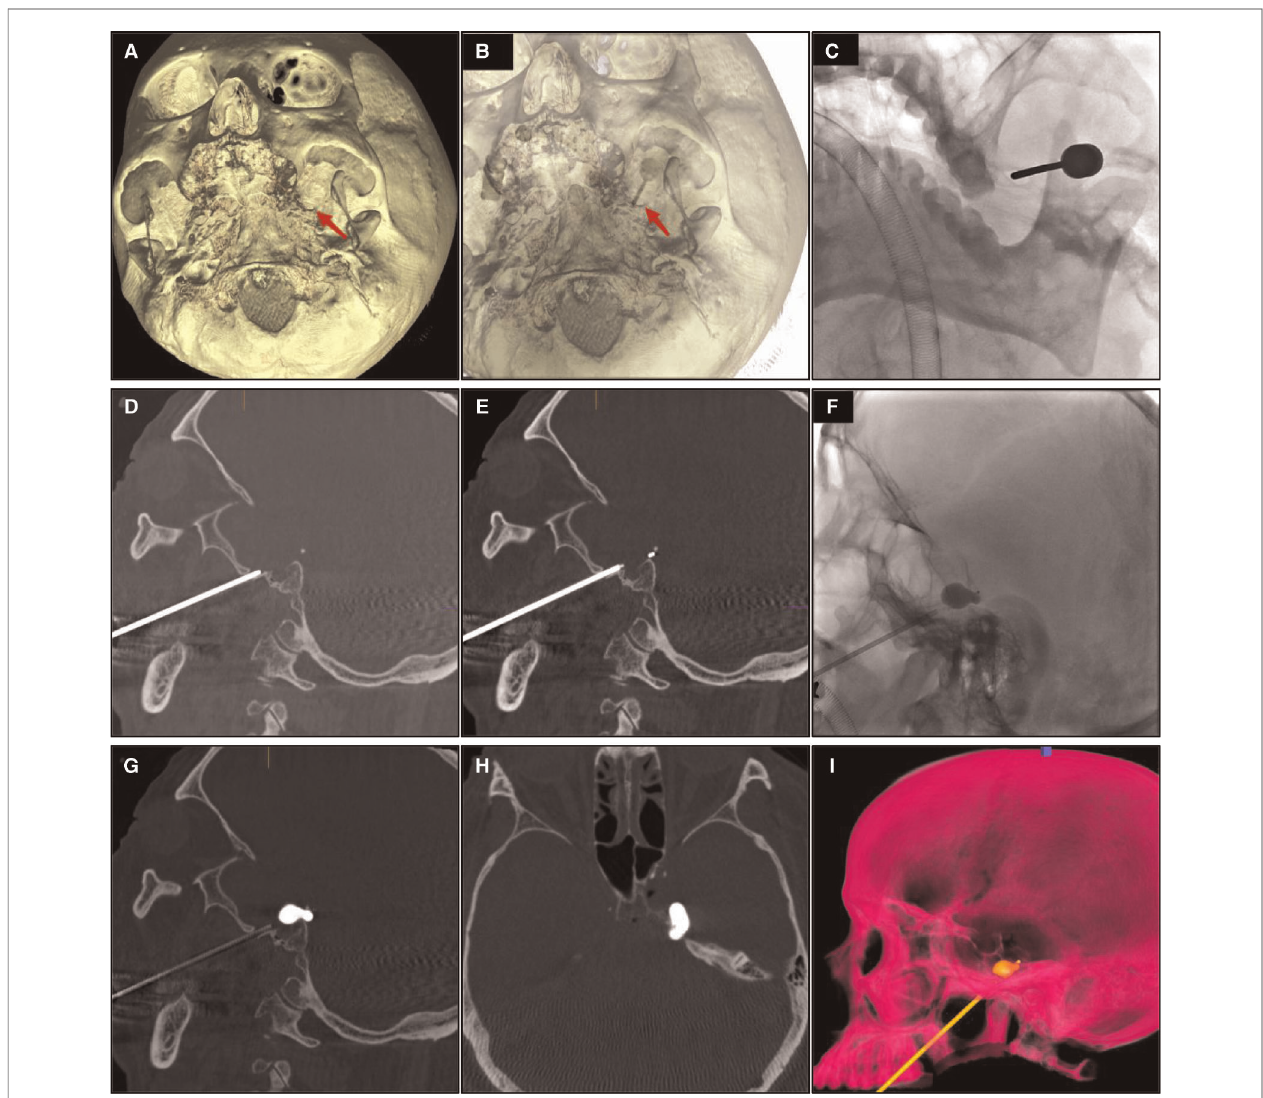
FIGURE 2 | ( A ) Intraoperative 3D reconstruction of the skull immediately after Dyna CT scan. ( B ) The FO puncture was performed under the 3D skull image. ( C ) The DSA dynamic fl uoroscopy. ( D ) Dyna CT scan was performed to adjust the direction and depth of the metallic HI to the correct position. ( E ) The distal mark of the FC was located at the apex of the Meckel chamber. ( F ) The balloon was fully in fl ated and pear-shaped. ( G ) Balloon morphology under Dyna CT (sagittal view). ( H ) Balloon morphology under Dyna CT (axial view). ( I ) Balloon morphology in 3D